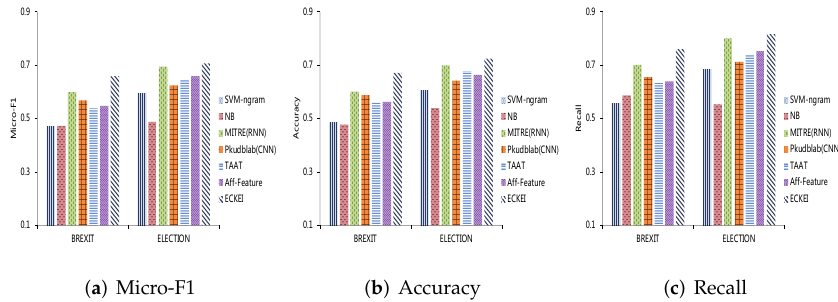
Figure 9. Micro-F1, accuracy and recall results on two datasets for the opposing stance. Table 4. Avg − MF1, Avg − Acc and Avg − Recall of our approaches on BREXIT and ELECTION.